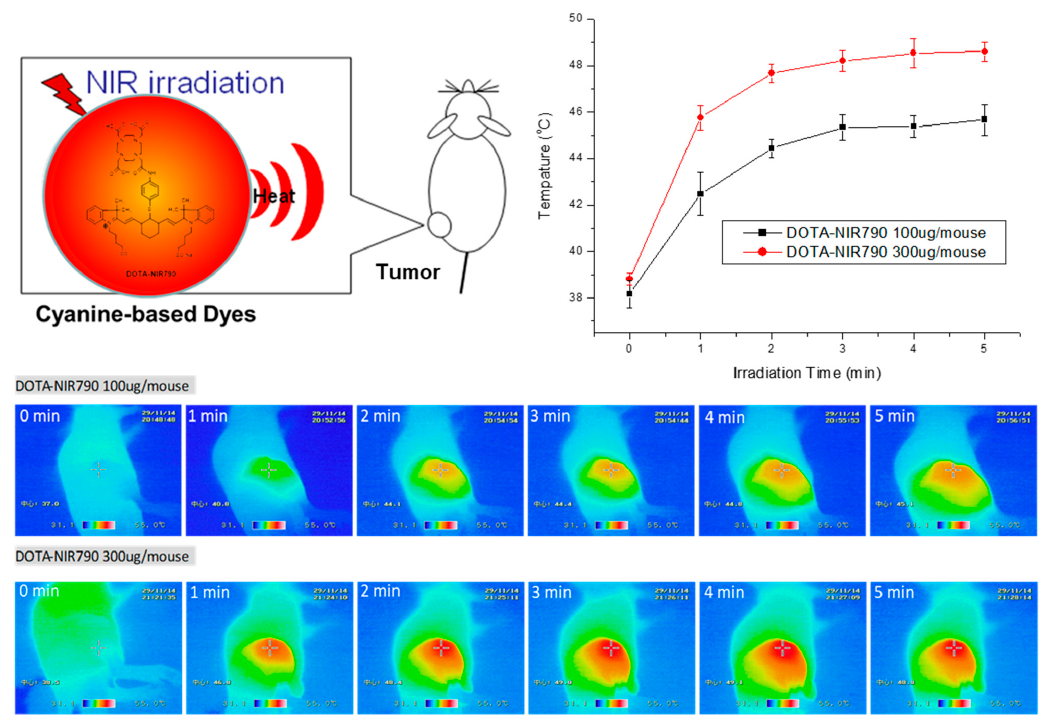
Figure 7. Tumor temperature measurement ( n = 3 at each time point) and infrared thermographic map during irradiation of DOTA-NIR790 based photothermal therapy. Int. J. Mol. Sci. 2021 , 22 , x FOR PEER REVIEW